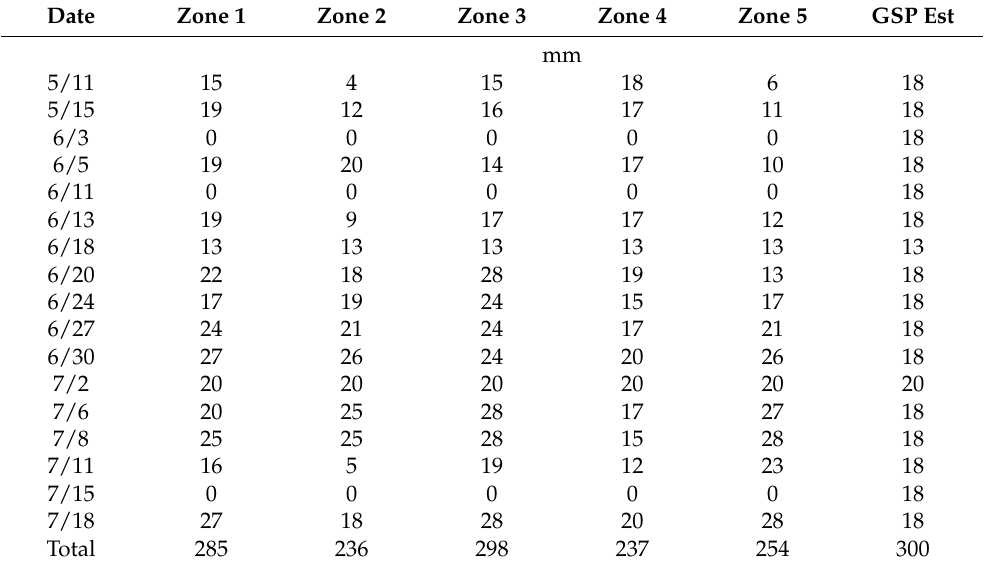
Table 1. Date of application and irrigation amounts within each of the five delineated irrigation zones throughout the 2019 growing season. Estimated grower standard practice (GSP) rates are compared to the rates of the other irrigation zones throughout the season. Uniform rates were applied on 6/18 and 7/2 for fertigation purposes.